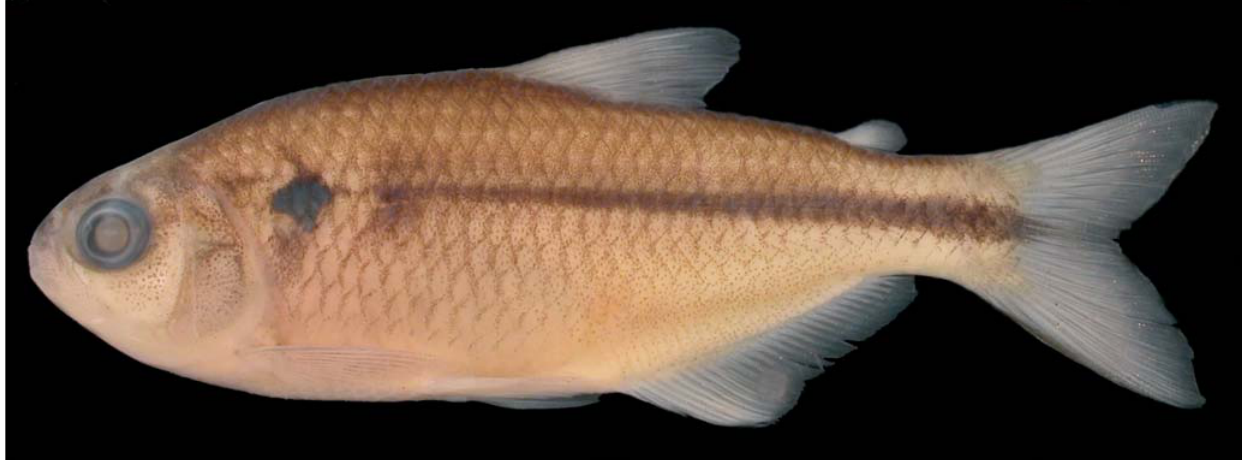
Fig. 1. Astyanax utiariti , MCP 40040, holotype, male, 67.8 mm SL; rio Papagaio, tributary of rio Juruena, upper rio Tapajós drainage, Sapezal, Mato Grosso,